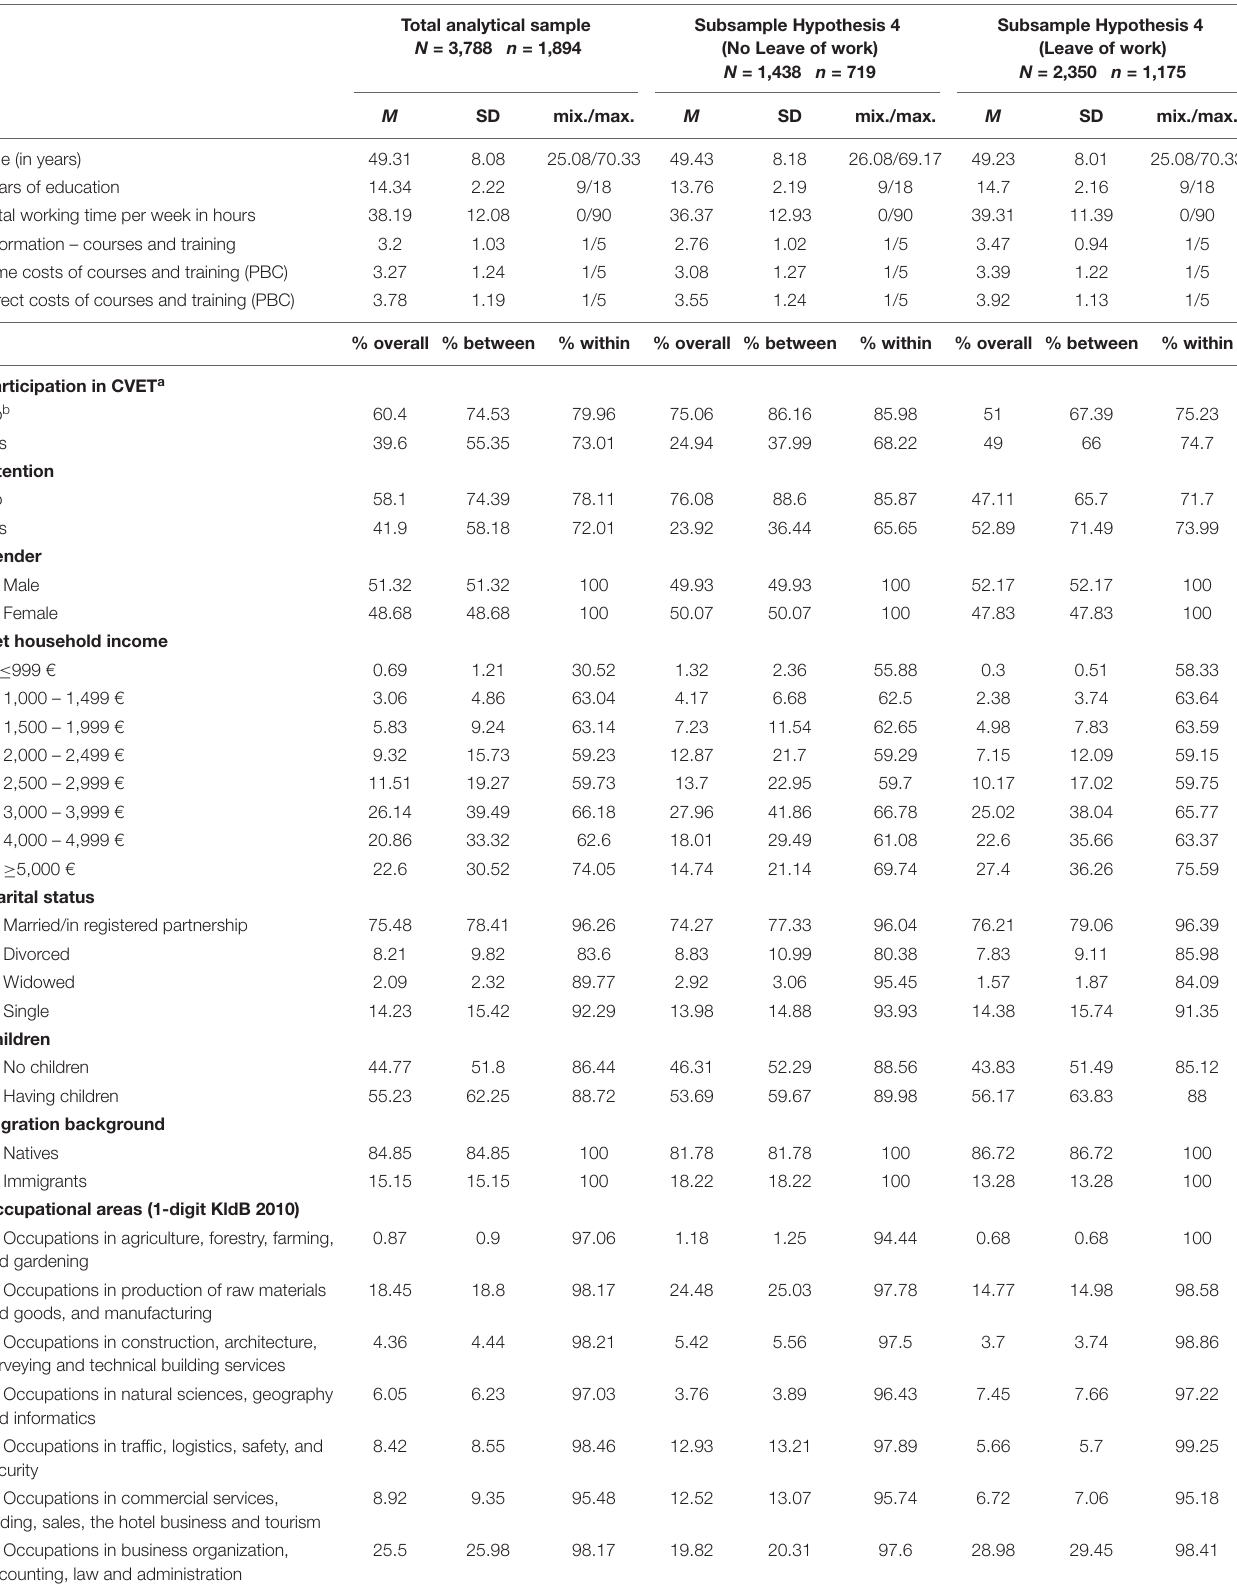
TABLE 1 | Descriptive statistics of the analytical